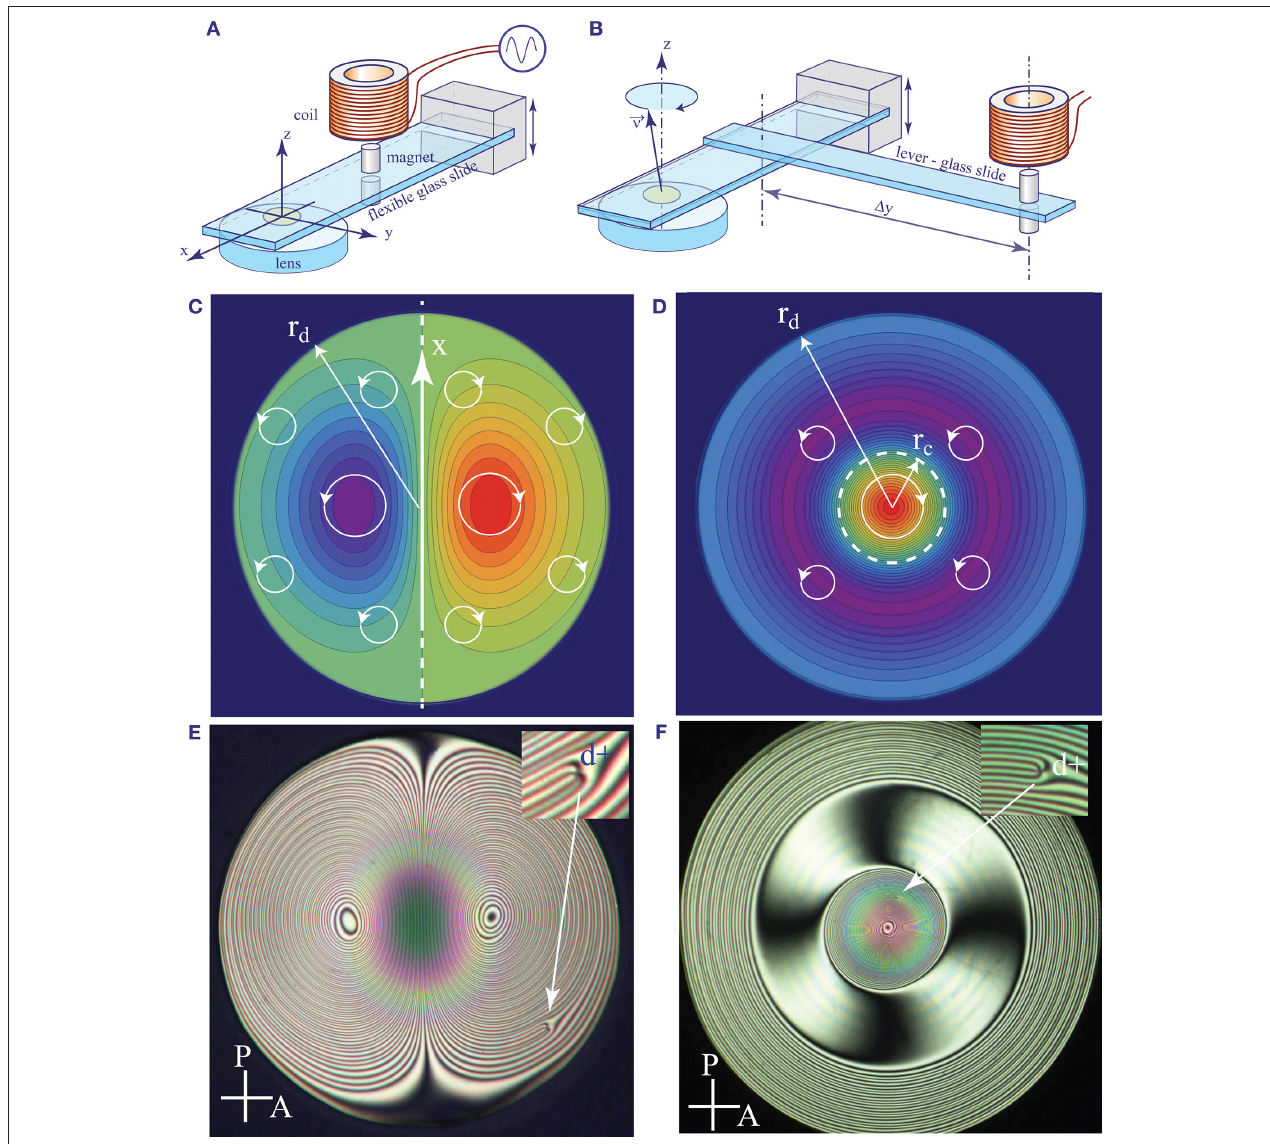
FIGURE 4 | Dowsons’ colliders. (A) The first version developed during studies of the rheotropism of the dowser texture [6]. Here, we will call it the Double Dowson Collider (DDC). (B) The second version tailored for production of circular trajectories of dowsons. We refer to it as the Circular Dowsons’ Collider (CDC). (C,D) Approximative representations of the rheotropic torque Ŵ ( x , y ) in DDC and CDC. (E,F) Typical wound up dowser textures obtained with DDC and CDC.